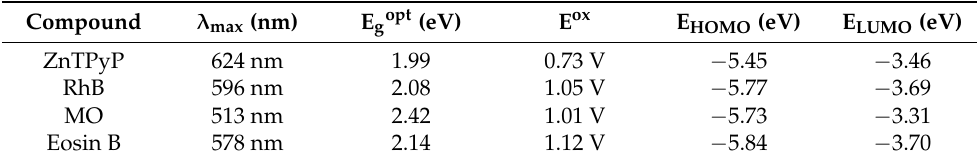
Figure 6. ( a ) Cyclic voltammograms of different dyes (test conditions: 0.1 M TBAPF 6 in methylene chloride solution as an electrolyte solution). ( b ) The UV − Visible absorption spectrum of different dyes. Table 1. Electrochemical starting potential and electronic energy level table of zinc porphyrin and different dyes.